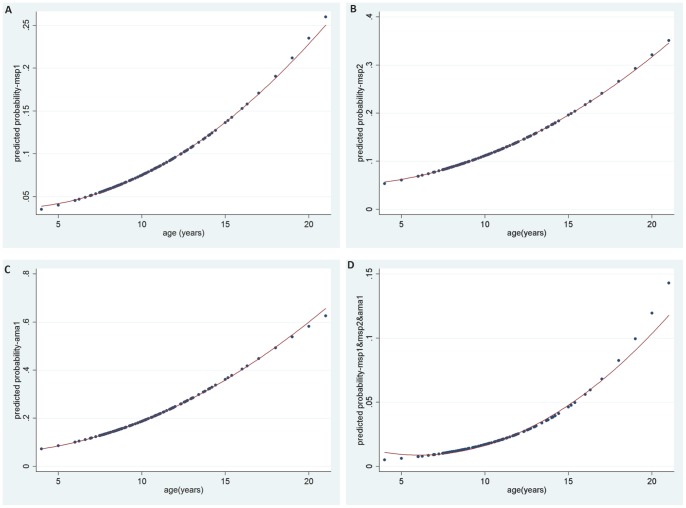
Age-specific seroprevalence.
A. MSP119. B. MSP2. C. AMA1. D. MSP119, MSP2 and AMA1(combined).